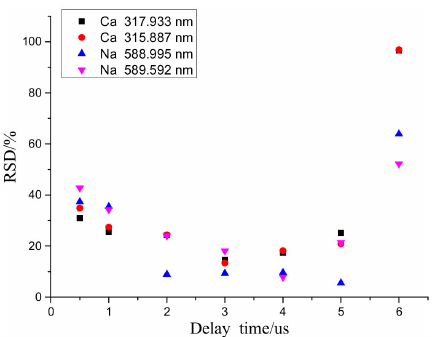
Figure 9. E ff ects of delay time on the repeatability of measurements on the elements